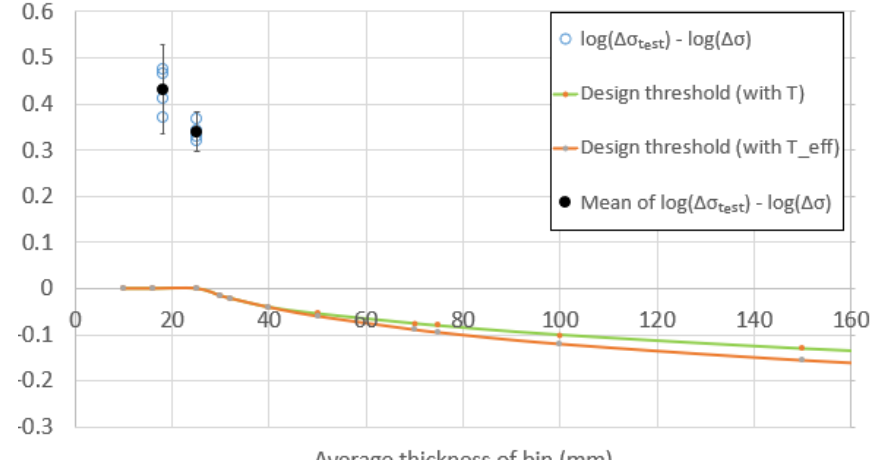
Figure 14. Data analysis of CP transverse butt-welded joints. Figure 18. Data analysis of FC transverse butt-welded joints . Figure 16. Data analysis of CP transverse butt-welded joints .